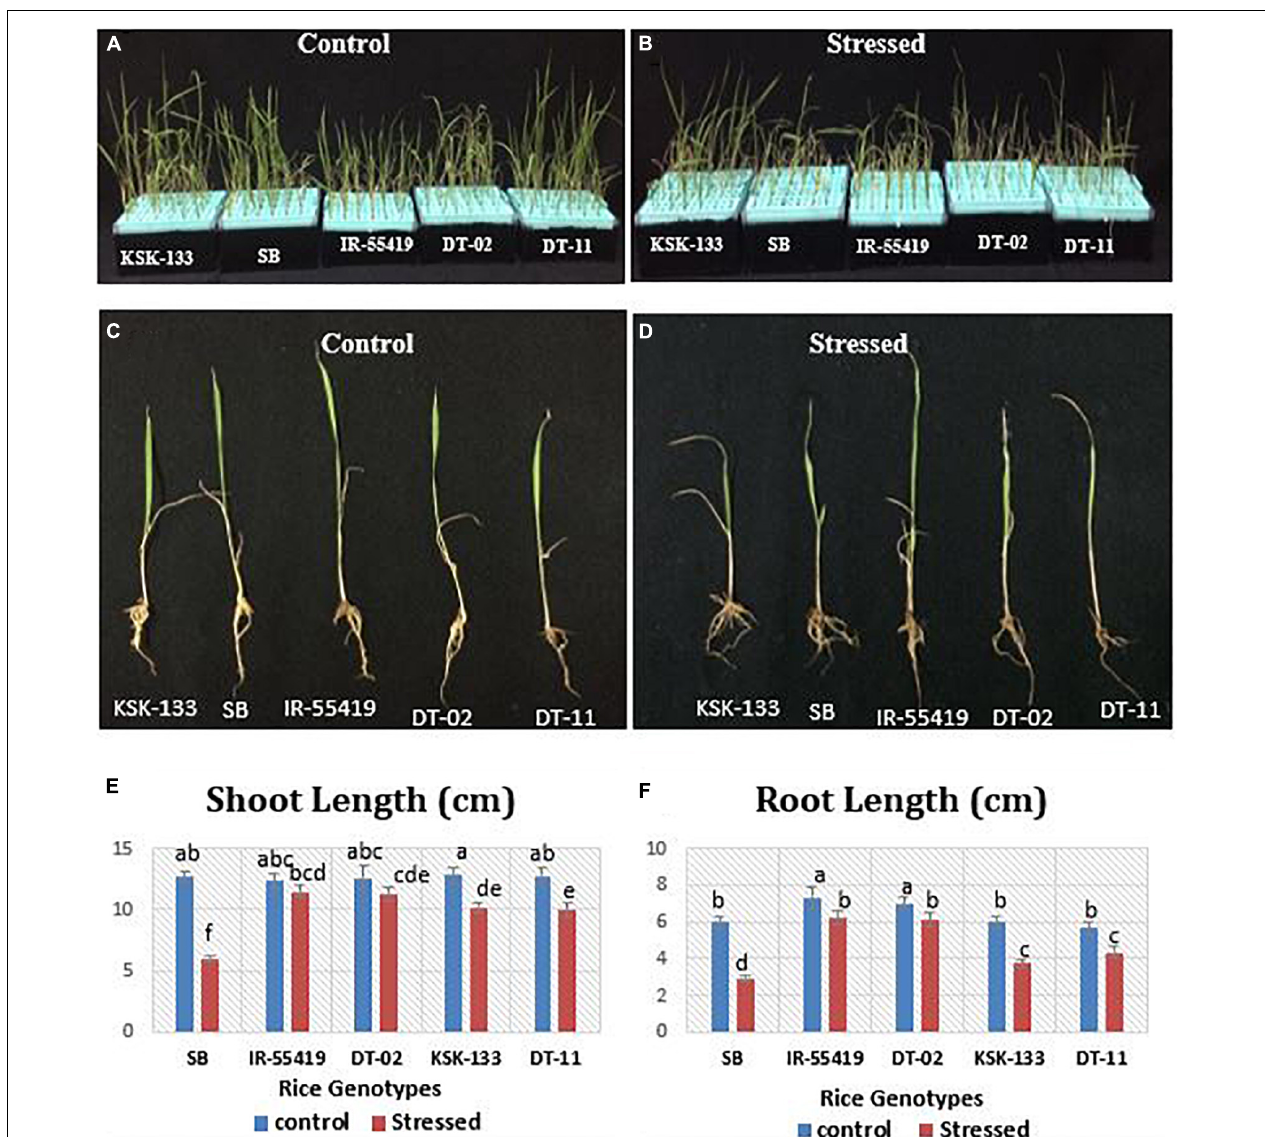
FIGURE 1 | Effect of osmotic stress on rice growth parameters under hydroponic conditions. Rice genotypes: Super Basmati (SB), IR-55419-04, NIBGE-DT-02, KSK-133, and DT-11. (A) Control-all tested rice genotypes without osmotic stress. (B) Stressed-osmotic stressed [20% Polyethylene Glycol (PEG)] rice seedlings in the hydroponic culture conditions. Morphological response of panel (C) . Plants of all tested genotypes under control- (without stress) and panel (D) . Plants of all tested genotypes under PEG mediated stressed. Graphical representation of panel (E) shoot lengths. (F) Root lengths under control-(without stress) and stressed-(20% PEG mediated osmotic